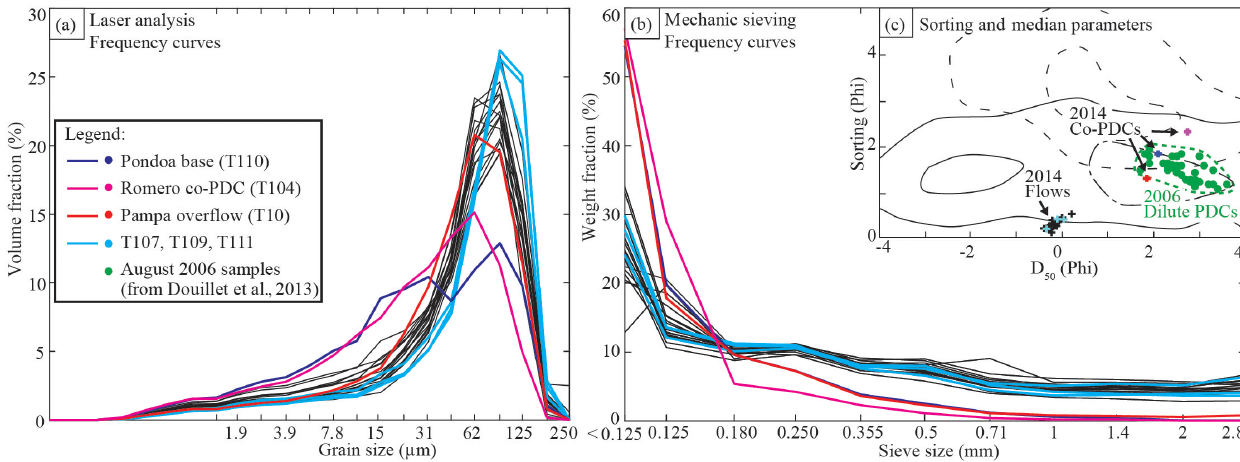
Figure 8. Grain-size analysis for samples from PDC deposits. Frequency curves for (a) laser and (b) mechanical sieving. (c) Sorting and median diameters calculated from the combined and interpolated curves for flows and co-PDC samples. Background: flow (dashed) vs. fall (plain) vs. surge (dotted) fields from Walker (1971) and dilute PDC samples from the August 2006 eruption in green.